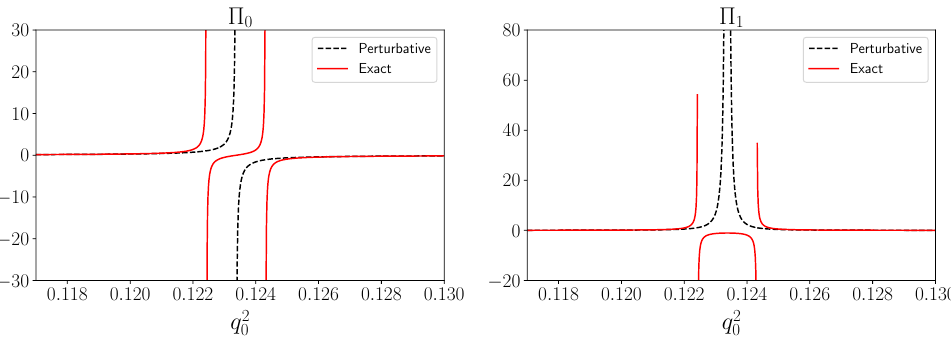
Figure 5 . The diagonal and non-diagonal elements of the matrix Π , given in eqs. (4.16) and (4.17). The quantity q 2 is given in eq. (2.3). It is seen that the quantity Π (1) 0 double pole instead of the two separated simple poles found in Π 1 (“exact”). Since this figure serves illustrative purpose only, we do not specify the values of the parameters in calculations. The units on the vertical axis are